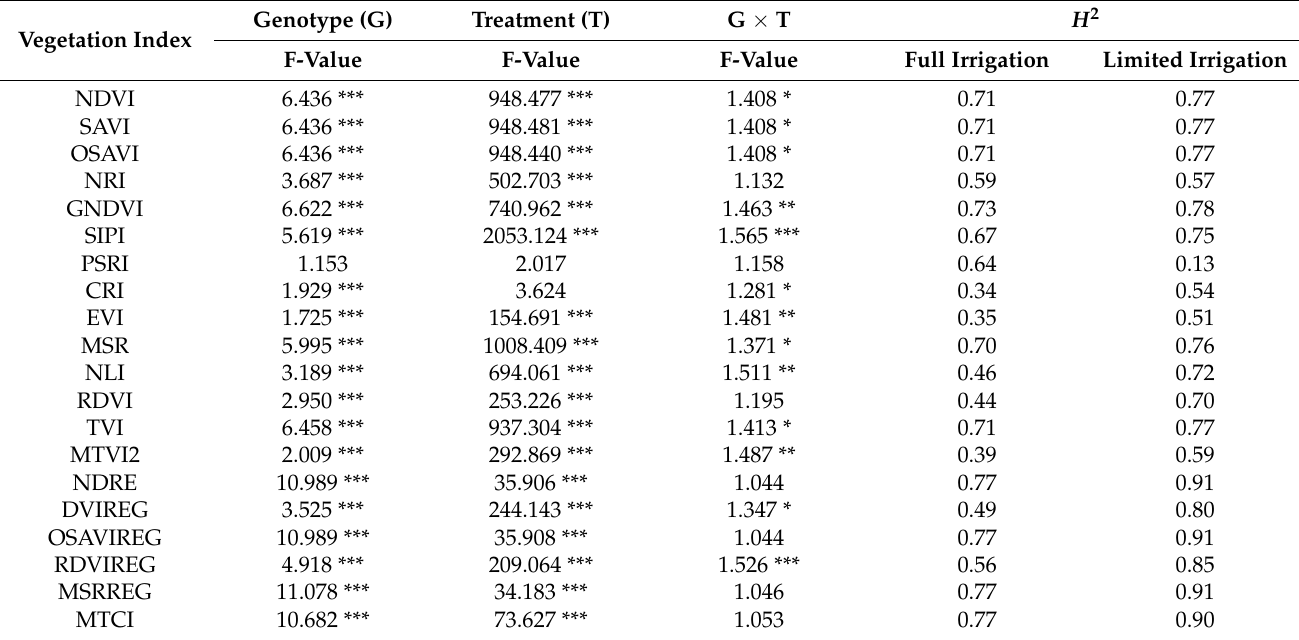
Table A3. Significance test and heritability of the vegetation indexes extracted in the flowering stage.